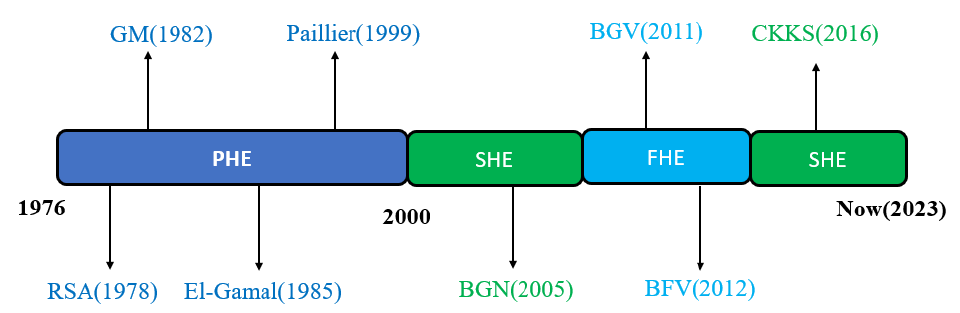
Figure 3. Timeline of some main schemes of each HE type (adapted from